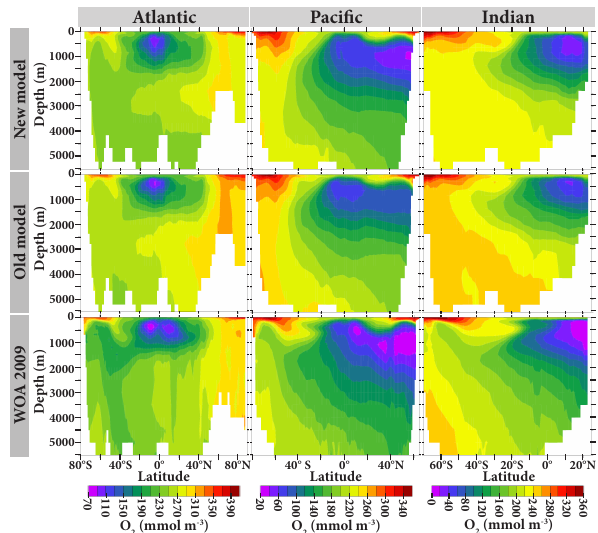
Fig. 7. Zonally averaged ocean basin comparisons of dissolved in- organic carbon between the new and old models and the GLODAP data set.